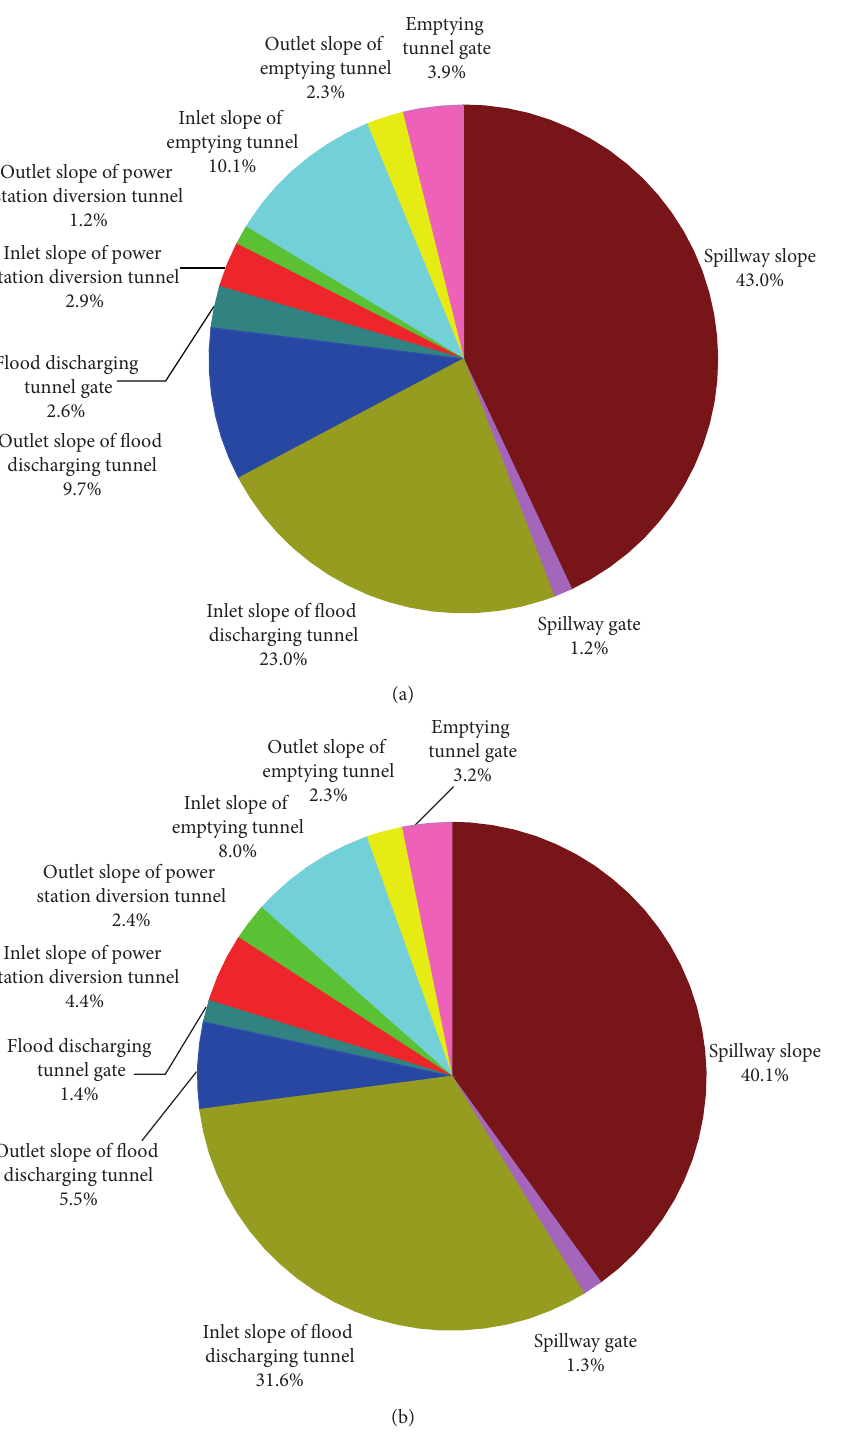
Figure 12: Results of sensitivity analysis for the impact of the change in failure probability of each bottom node on the dam overtopping risk for (a) case I and (b) case